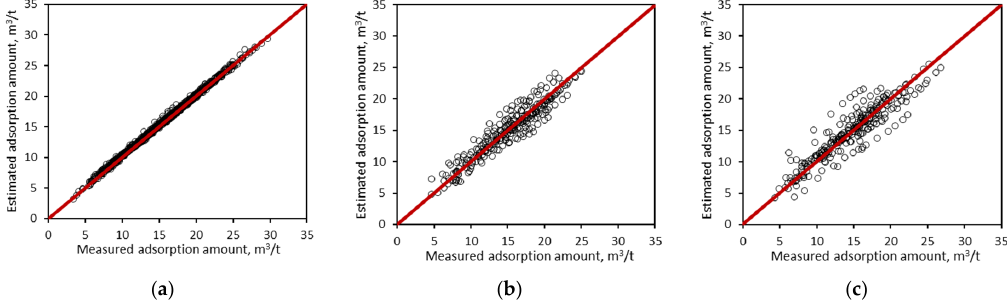
Figure 8. Cross plot of the BP-ANN estimated versus measured adsorption amounts for the ( a ) training, ( b ) validation, and ( c ) testing sets. Open circles are data points; red lines are 45-degree lines.